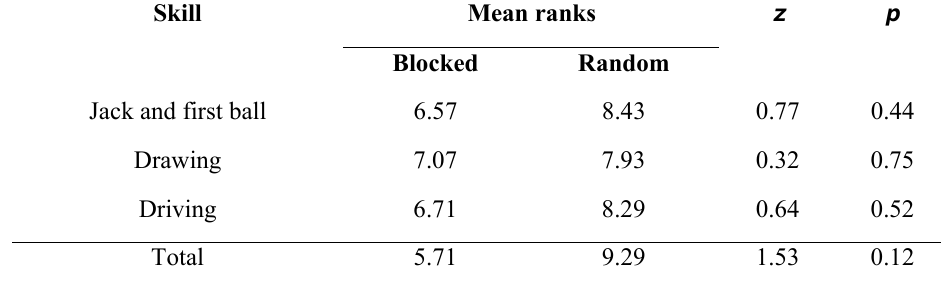
Note . All mean ranks (pre- and post-) have been omitted Results of 2-Samples Mann-Whitney U Test for Differences between Blocked and Random Training Schedule Pre- and Post- Tests